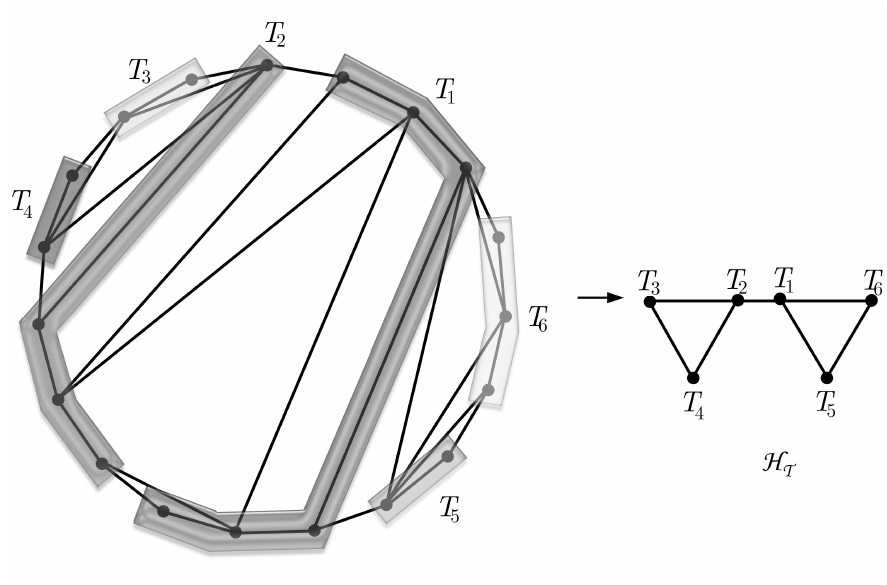
Fig. 3. T 1 is a forcing tree with an inner edge in its edge